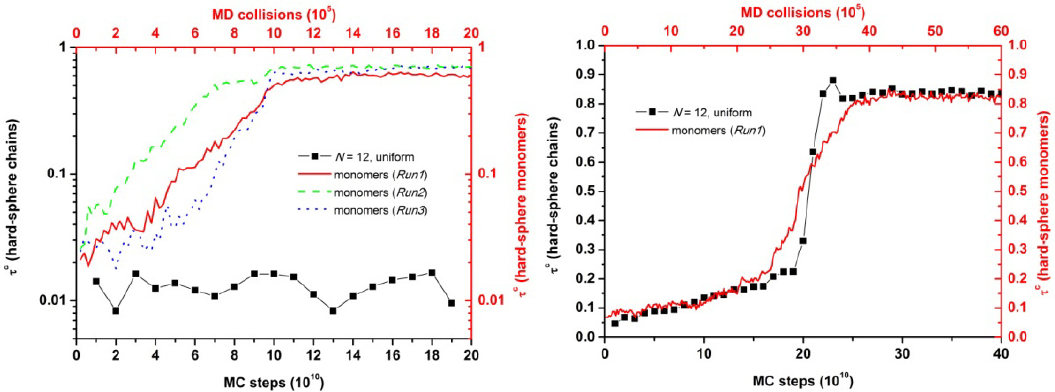
Figure 3. Crystallinity, , as a function of MC steps and Molecular Dynamics (MD) collisions as obtained from simulations of freely-jointed chains of tangent hard spheres. = 12, uniform chain length distribution) and on monomeric hard spheres, respectively ( N av through application of the CCE norm, at ( left ) a packing density of where Run1 , Run2 and Run3 denote MD trajectories starting from Frames 0, 10 10 and 19 × 10 10 , respectively, of the corresponding MC trajectory by deleting all existing bonds, ( right ) φ = 0.61, where in Run1 monomeric MD simulation is initiated from Frame 10 9 of the corresponding MC trajectory.